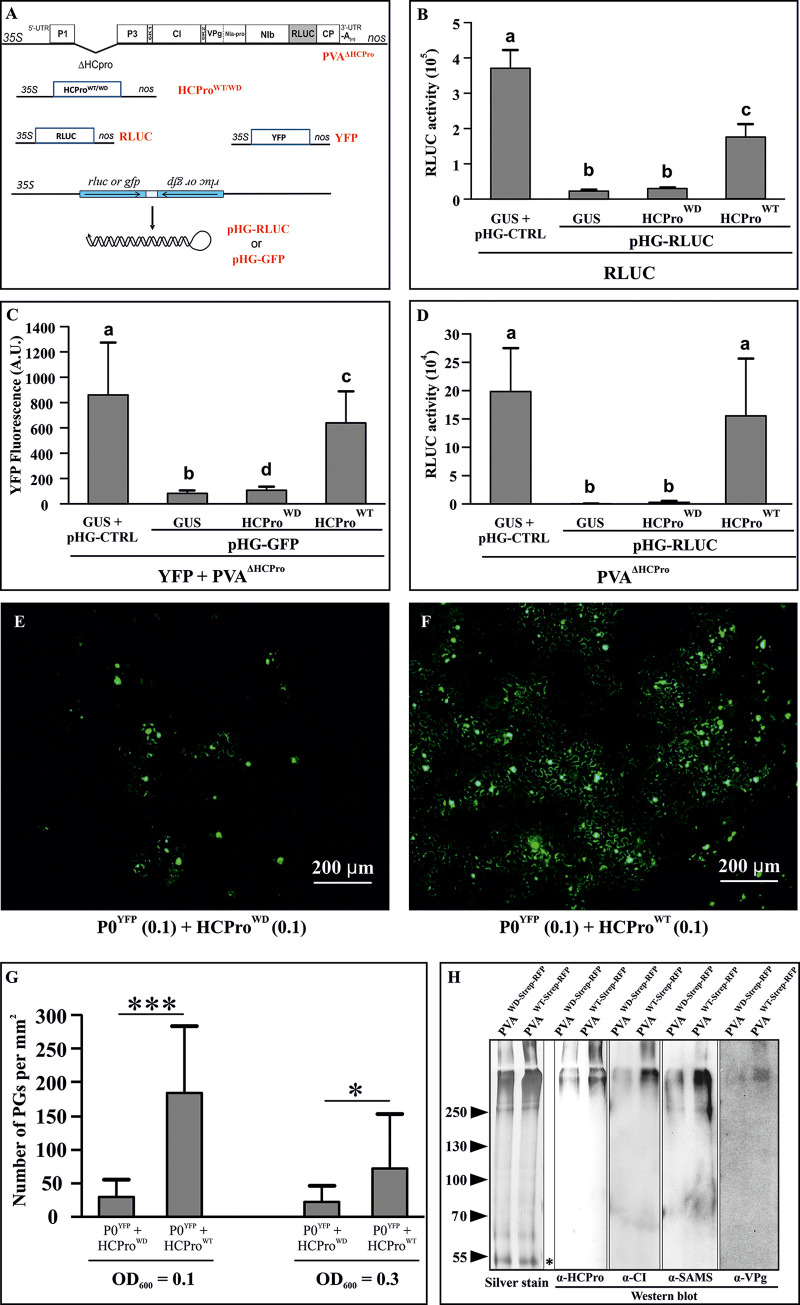
HCProWD is defective in suppressing hairpin-triggered RNA silencing, inducing PGs and forming infection associated HMW complexes.(A) A schematic representation of the constructs used to study the suppression of hairpin-triggered RNA silencing. The hairpin RNAs (pHG-RLUC and pHG-GFP) targeting monocistronic RLUC, YFP, and RLUC-expressing PVA RNA were expressed to trigger RNA silencing. HCProWD and HCProWT were expressed to test their capacity to suppress RNA silencing. (B) The capacity of HCProWD to suppress RNA silencing. N. benthamiana plants were agroinfiltrated with the RLUC expression construct (OD600 = 0.01), pHG-RLUC construct (OD600 = 0.4) and HCProWD / HCProWT constructs (OD600 = 0.3) as indicated. Empty pHG-CTRL and GUS were expressed as the controls. All constructs were co-infiltrated and the samples were analyzed for RLUC activity at 3 dpi. (C) The effect of other PVA proteins on HCProWD’s capacity to suppress RNA silencing. Agrobacterium carrying YFP expression construct (OD600 = 0.01) and pHG-GFP (OD600 = 0.4) were co-infiltrated as in (B) with HCProWD / HCProWT and PVAΔHCPro (OD600 = 0.1). YFP fluorescence was quantitated from leaf discs collected at 4 dpi using a 96-well plate reader at Ex/Em 500/530 nm [51]. (D) Suppression of RNA silencing targeting PVA RNA-derived RLUC expression. The experimental setup was similar to that of (B). Agrobacterium carrying PVAΔHCPro was infiltrated at OD600 = 0.05. RLUC activities were measured from samples collected at 3dpi. The number of plants equals 4 (n = 4) in (B), n = 9 in (C) and n = 6 in (D). Different letters above the bars indicate a statistically significant difference (student’s t-test *P < 0.05). (E, F) Variation in the amount of PGs during transient expression of HCProWD (E) and HCProWT (F) infiltrated at OD600 = 0.1. P0YFP was co-expressed at OD600 = 0.1 to visualize PGs. Samples collected at 3 dpi were examined with an epifluorescence microscope under an FITC filter. (G) Amount of PGs induced by HCProWD / HCProWT overexpression. HCProWD / HCProWT were agroinfiltrated at OD600 = 0.1 and 0.3 as indicated, while P0YFP was agroinfiltrated at OD600 = 0.1. The number of PGs per mm2 was calculated from nine independent areas. Asterisks denote statistical significance between the sample sets (student’s t-test *P < 0.05, ***P < 0.001). (H) TwinStrep tag-affinity purifications were carried out from leaf samples collected at 3 dpi from plants infiltrated with either PVAWD-Strep-RFP or PVAWT-Strep-RFP (OD600 = 0.1). The purification resulted in the pulldown of HCPro along with its in vivo binding partners. Purified proteins were analyzed by western blotting using α-HCPro, α-CI, α-SAMS and α-VPg antibodies, respectively. All the blots were made from the same gel by cutting the PVDF membrane into strips after the transfer. In addition, two lanes of the same gel were silver-stained. The low molecular weight bands marked with asterisk demonstrates equal loading of the HCProWD-Strep-RFP and HCProWT-Strep-RFP samples.